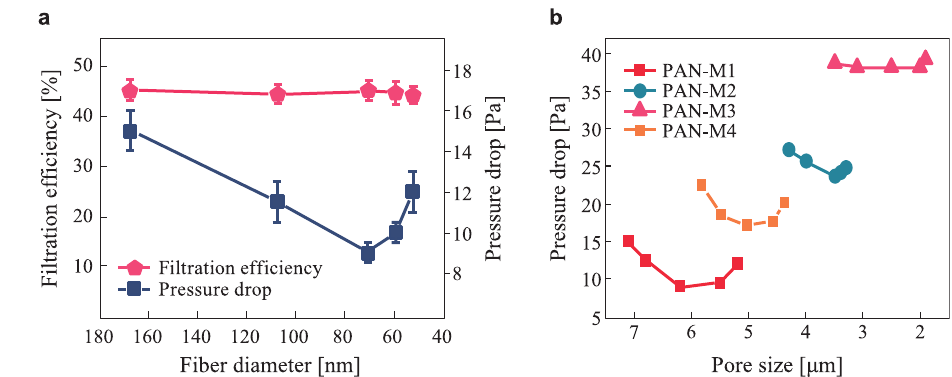
Fig. 3 Changes in pressure drop by fiber diameter, cited from Ref. (Zhao et al., 2016). Copyright: (2016) The Author(s).